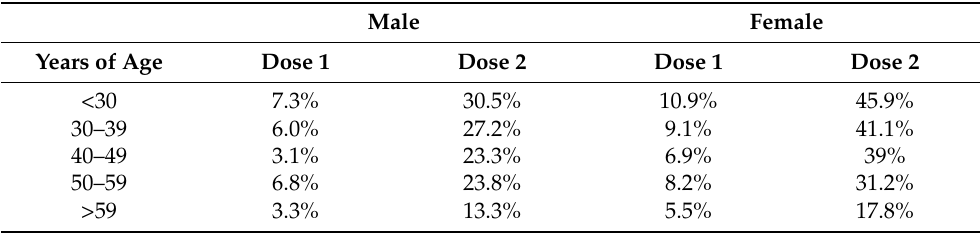
Table 5. Percentage of participants unable to work for at least one day after first and second dose of BNT162b2